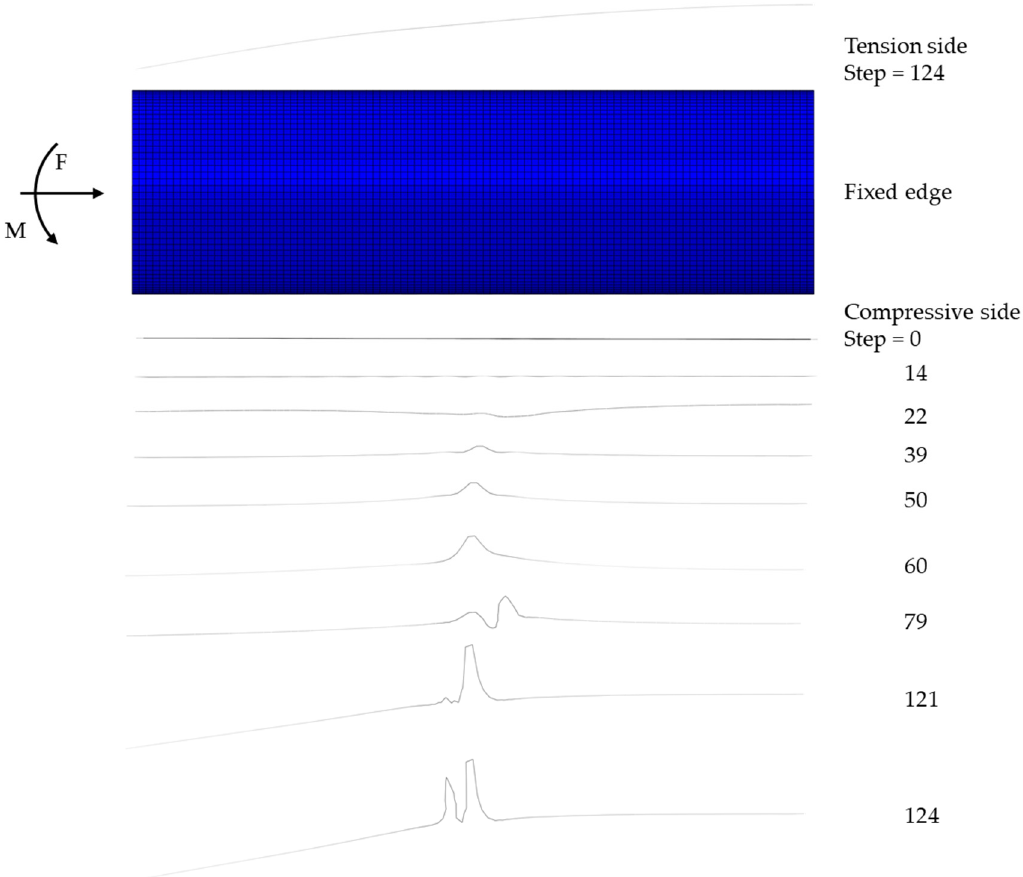
Figure 15. Shell (20 m at 24 mm) longitudinal surface displacement under combined loading, (scale factor = 5).